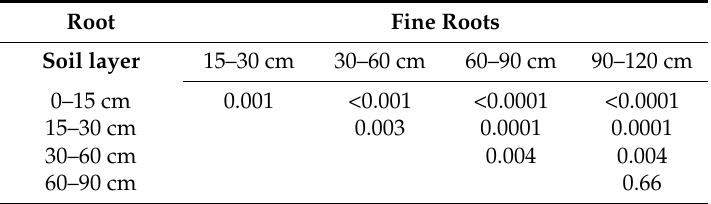
Table A3. The p values of the multiple comparisons of factors, slope positions and soil layers, for root densities by the Shaffer’s modified sequentially rejective Bonferroni